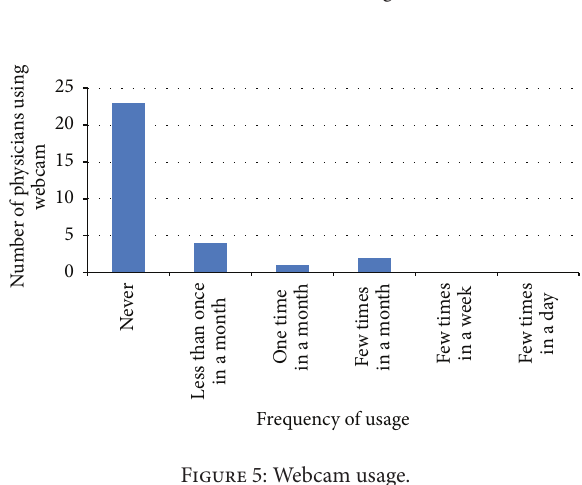
Figure 4: Website usage.